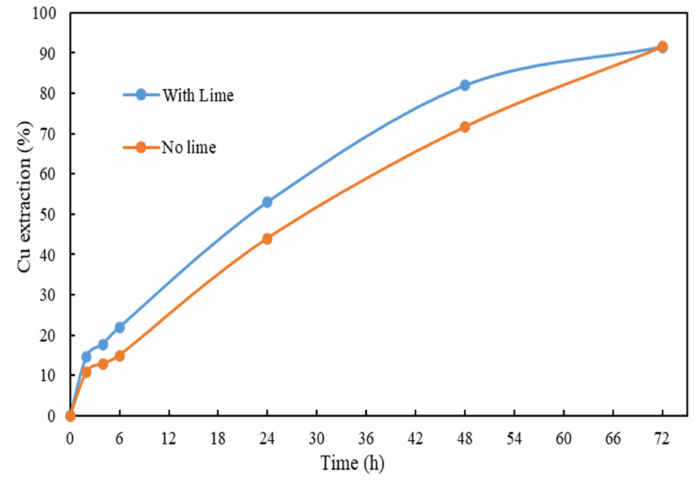
Figure 7. Cu extraction after 72 h of leaching using glycine–ammonia system with/without adding lime. Other conditions: solid/liquid ratio = 1%, room temperature and ceramic beads: solid = 3:5.